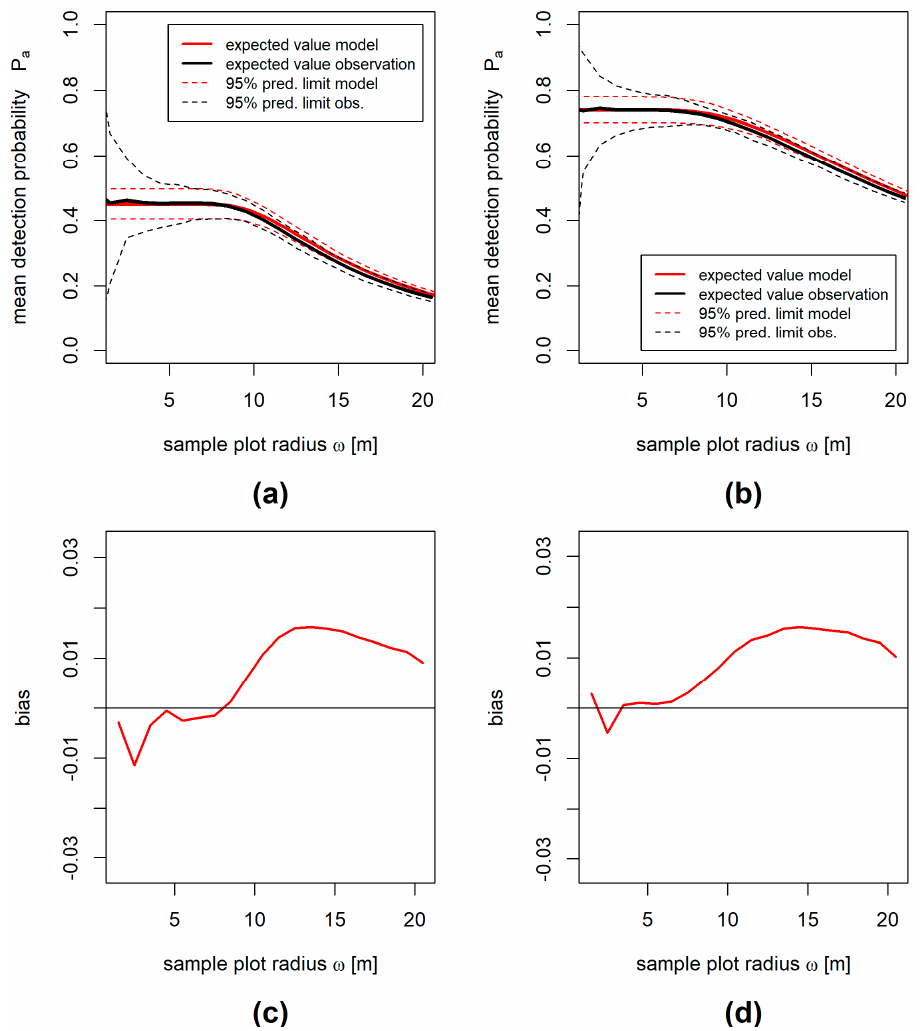
Figure 5. Results of the simulation study (200 simulation runs of 25 sample plots) for both strata, using annuli of 1 m widths for model fitting to the simulated single-scan data. ( a , b ) Mean detection probability P a for di ff erent sample plot radii ω using simulated TLS in multi-scan mode. The solid black line represents the expectation of the simulated data; the solid red line represents the expectation of the model prediction. The dashed lines represent the corresponding 95% prediction limits, i.e., the 2.5% and 97.5% quantiles of the 200 simulation runs. ( c,d ) Model bias dependent on the sample plot radius. ( a , c ) Small trees (5 cm ≤ dbh < 20 cm) and ( b , d ) large trees (dbh ≥ 20 cm).